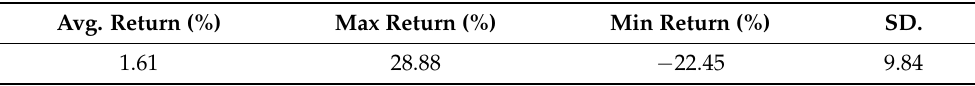
Table 5. Statistics of average return performance from BO